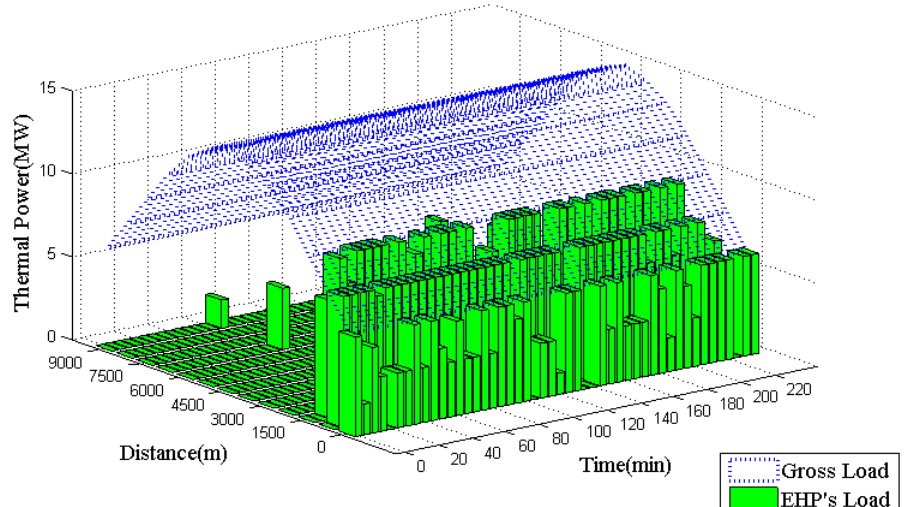
Figure 13. Configuration of Space Heating Load (COP =